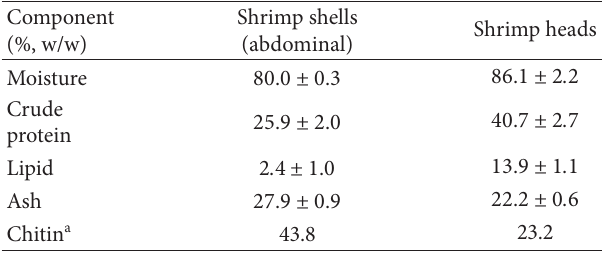
Table 1: Chemical properties of shrimp shells and heads.